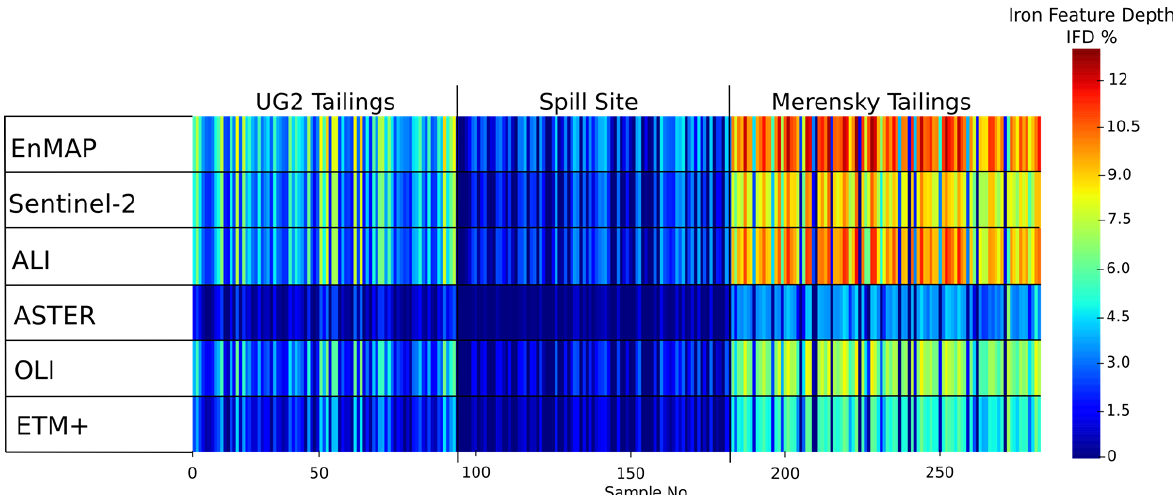
Figure 9. Iron feature depth analysis of in situ ASD field-spectroscopy data from the PGE tailings material spectrally resampled to different multispectral sensors. The performance of the multispectral sensors is directly visible, with Sentinel-2 and ALI performing well compared to the weaker signal in the OLI data, whilst ASTER and ETM+ show the least resemblance to the EnMAP IFD.